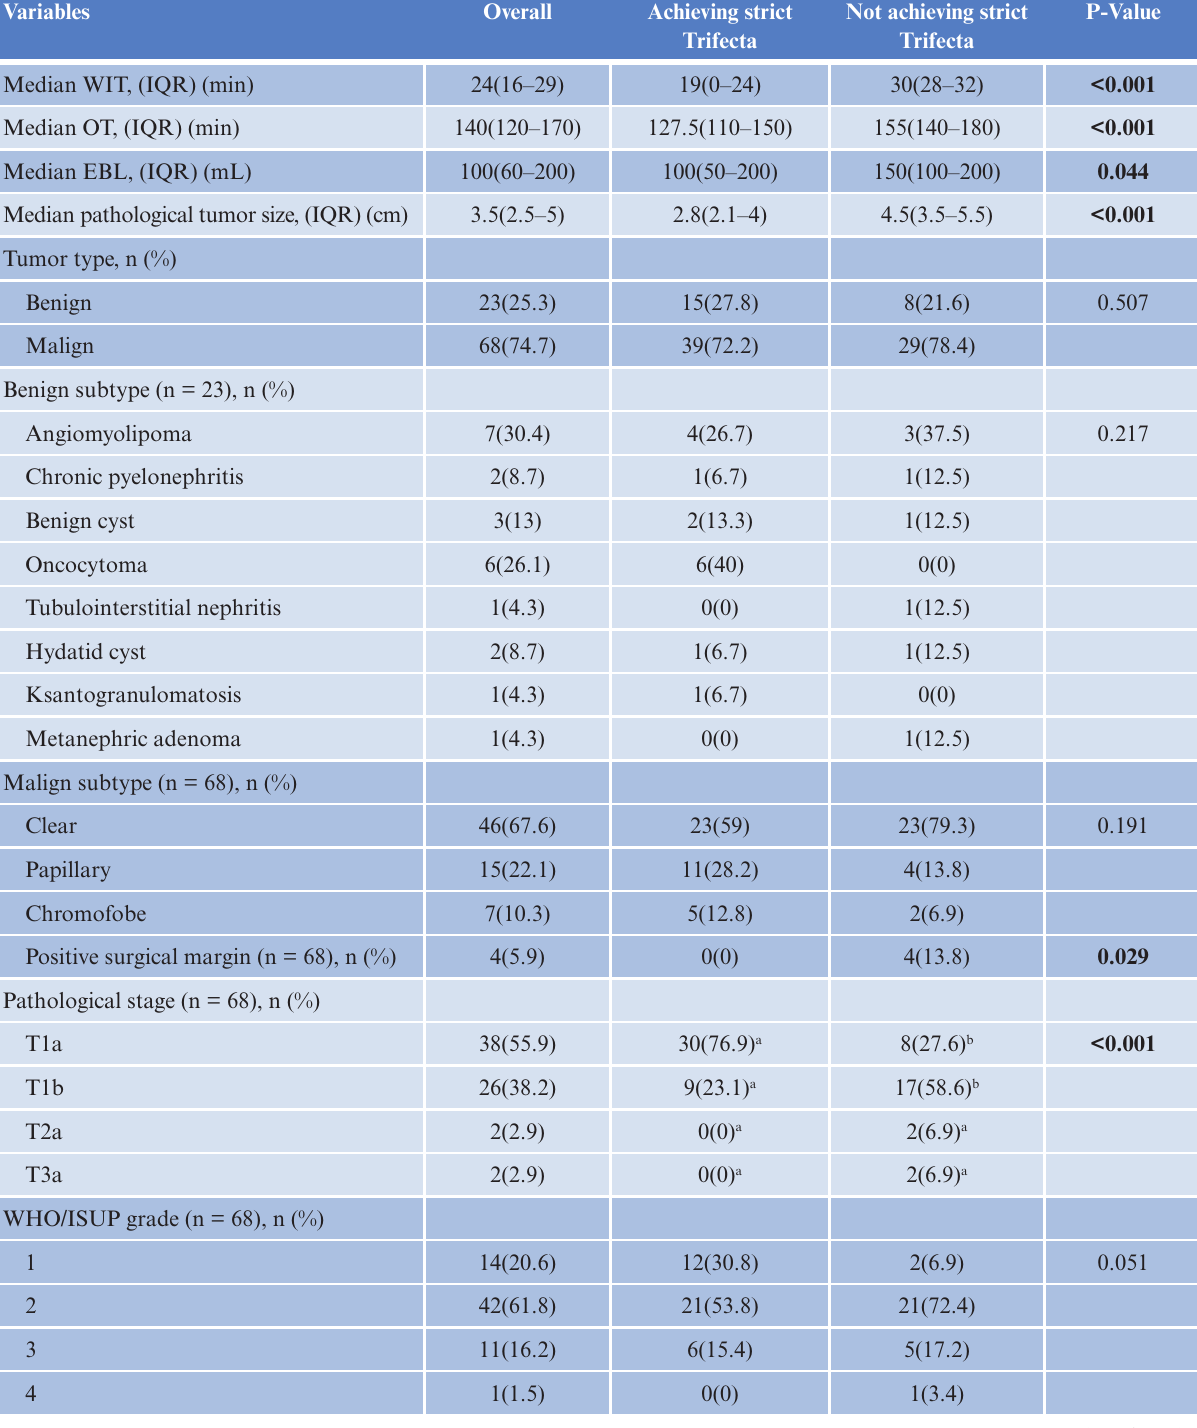
Table 2: Perioperative outcomes and pathological